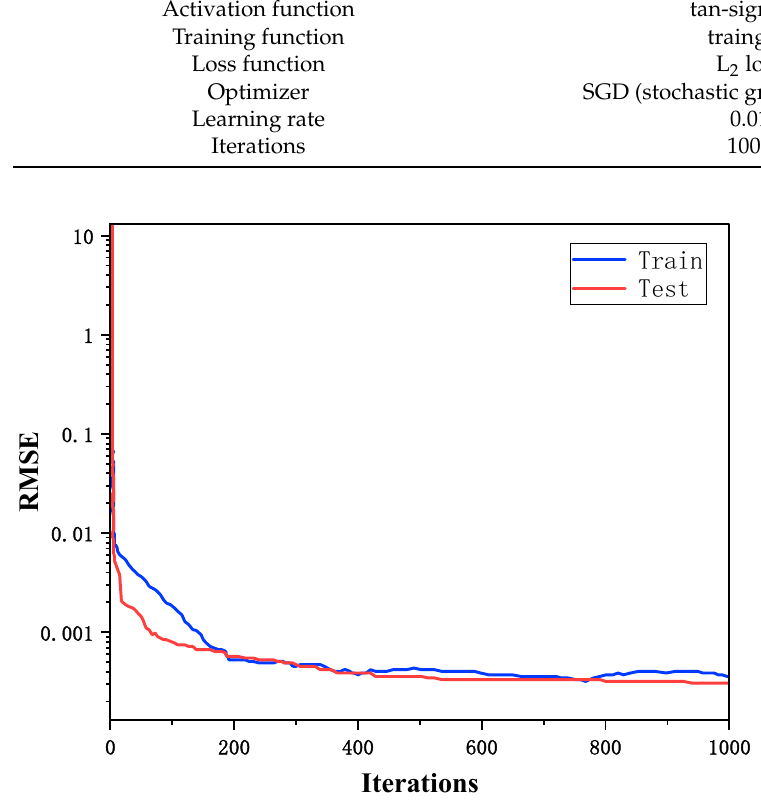
Table 2. Training parameter settings of ARIMA-BPNN.